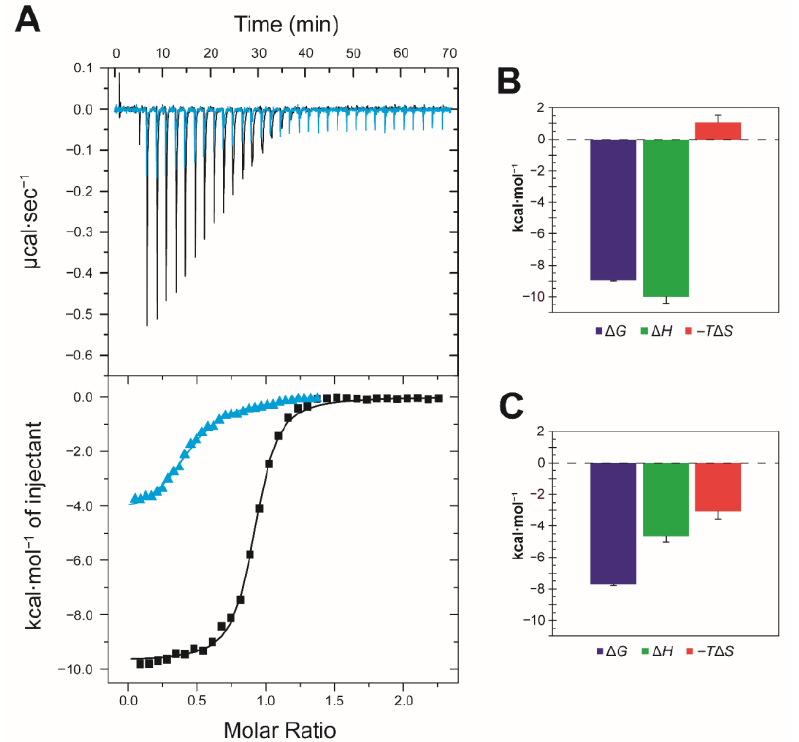
Figure 6. ( A ) Superposition of the ITC titration curves of the heart-type fatty acid-binding protein (FABP3) interaction with C18:1(n-9) c in black and C18:1(n-9) c -carnitine in cyan. Both experiments were performed in 20 mM K 2 HPO 4 /KH 2 PO 4 , 50 mM KCl buffer pH 7.6 (KPi) at 25 °C. Graphical representation of the thermodynamic binding parameters of the FABP3 interaction with ( B ) C18:1(n-9) c and ( C ) C18:1(n-9) c -carnitine.